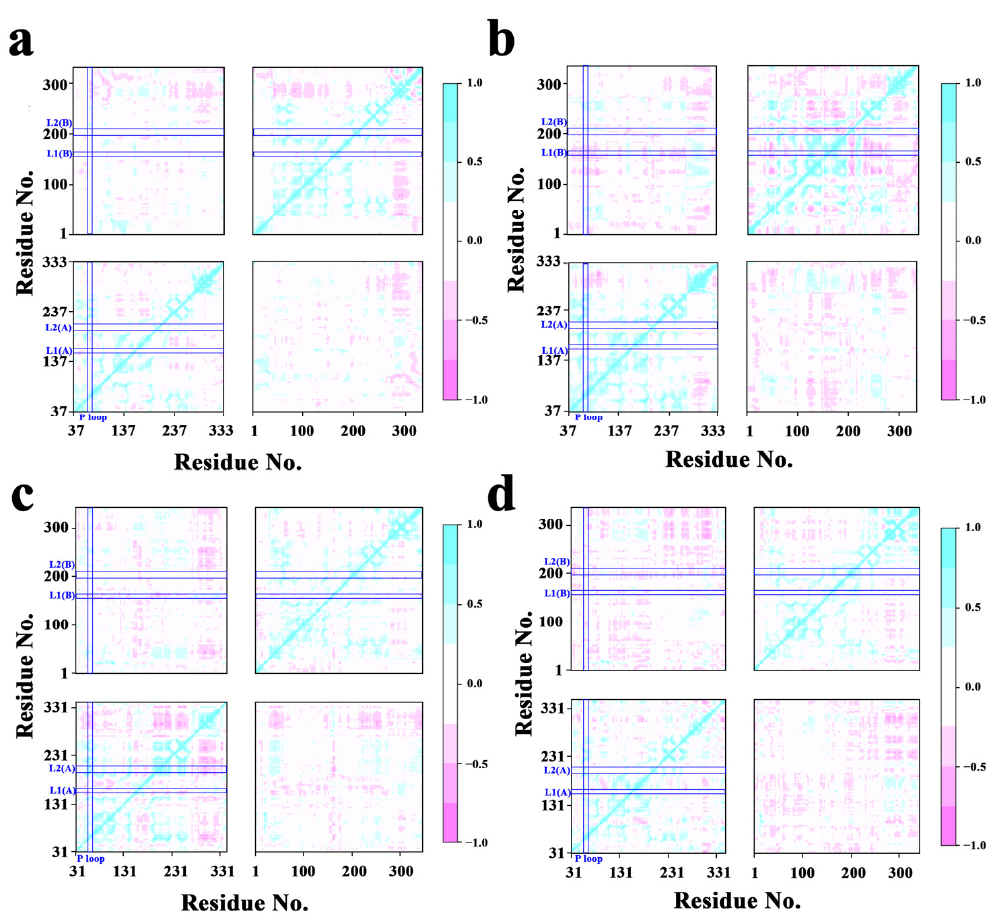
Figure 3. Cross-correlation matrices between residues. ( a ) 298 K RecA; ( b ) 310 K RecA; ( c ) 298 K UvsX; ( d ) 310 K UvsX.